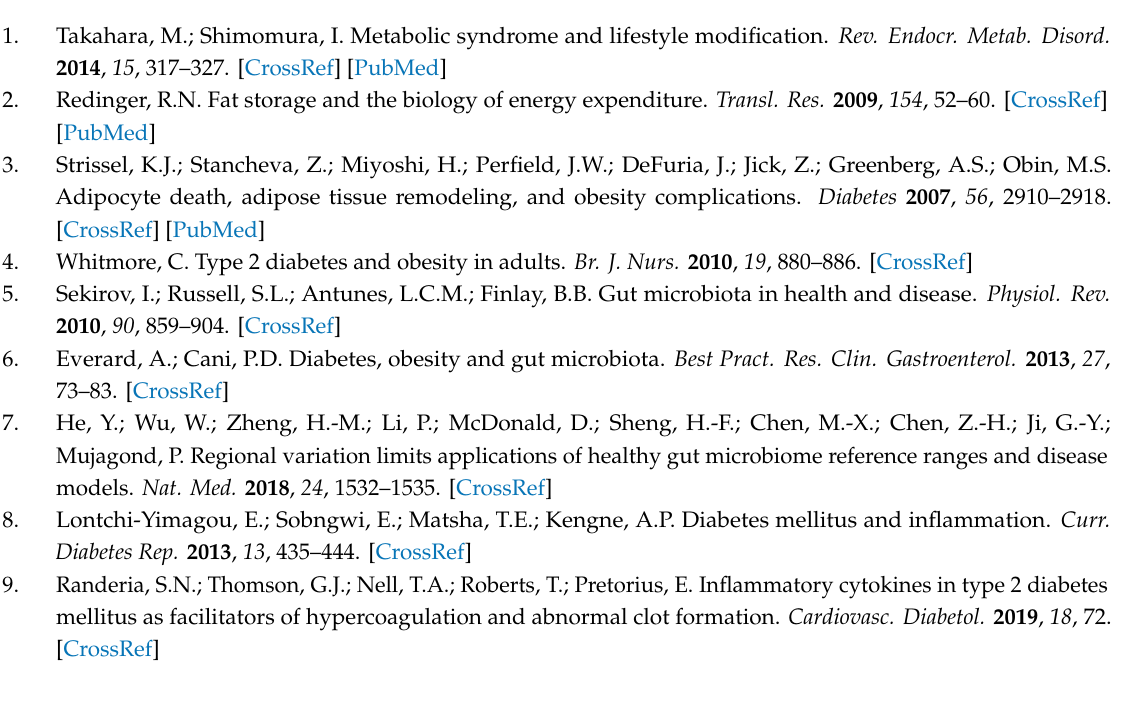
Figure S1: The correlation between Turcibacter, Clostridiaceae and fasting blood glucose, Table S1: Composition of experimental diets (% of diet, w / w), Table S2. E ff ects of 16-week D-allulose supplementation on plasma adipokine and cytokine concentrations in C57BL / 6J mice fed a high-fat diet, Table S3. he numbers of up- or down-regulated genes in epididymal white adipose tissue D-allulose group compared to the high-fat diet group, Table S4. The list of up- or down-regulated genes in hepatic tissue by allulose among the high-fat diet-responsive genes. Author Contributions: Y.H. performed the experiments, analyzed the data, and wrote / edited the manuscript. E.-Y.K. and M.-S.C. supervised this work and had full access to all the data and therefore took full